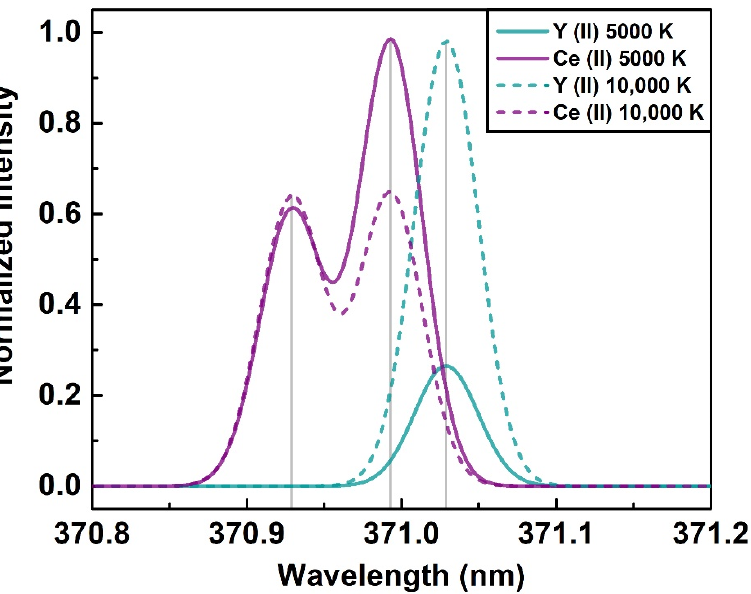
Figure 2. Simulated emission spectra of Ce (II) 370.929 nm, 370.993 nm and Y (II) 371.029 nm at different plasma temperatures.